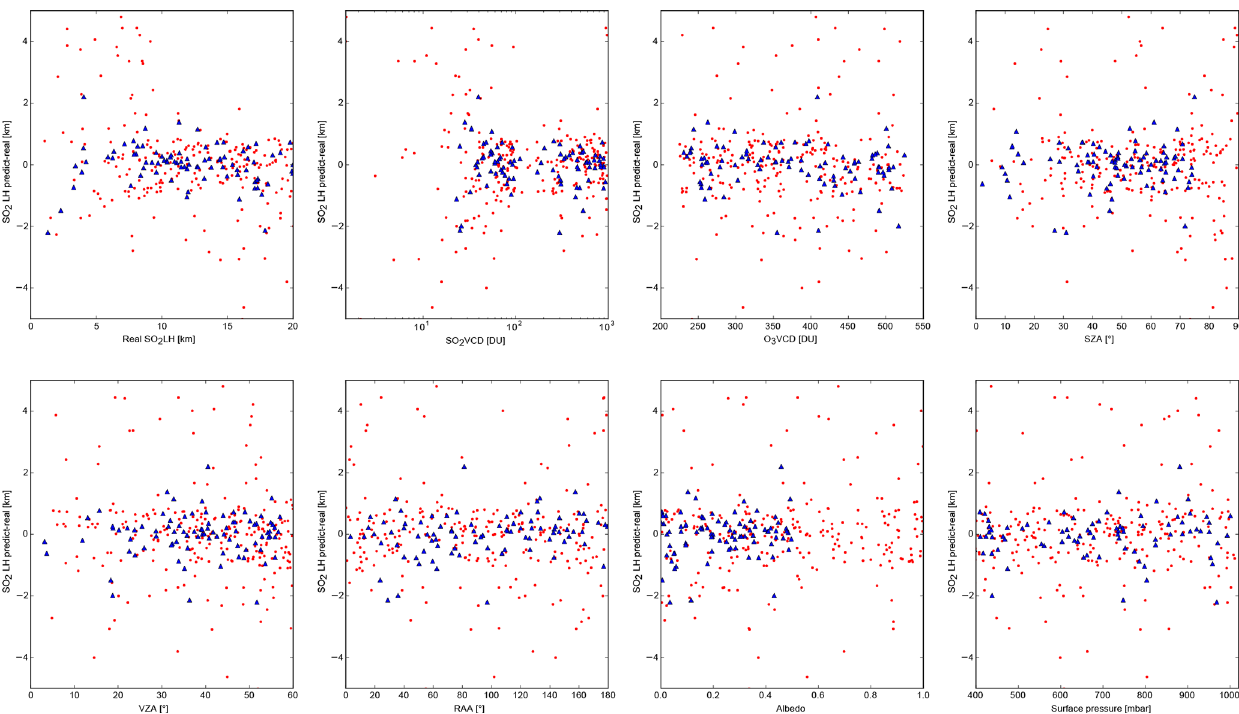
Figure 2. Dependency of the retrieved SO 2 layer height as a function of eight parameters as indicated. Plotted are the layer height differences (in km) between the retrieved layer heights and those simulated using the independent verification dataset (i.e., a 10% subdivision of the entire training dataset). Red dots show the dependencies using the entire training dataset, whereas blue triangles show the dependencies with an optimized training dataset (i.e., restricted to SO 2 VCD values greater than or equal to 20DU, SZAs less than or equal to 75 ◦ , and albedos less than or equal to 0.5).